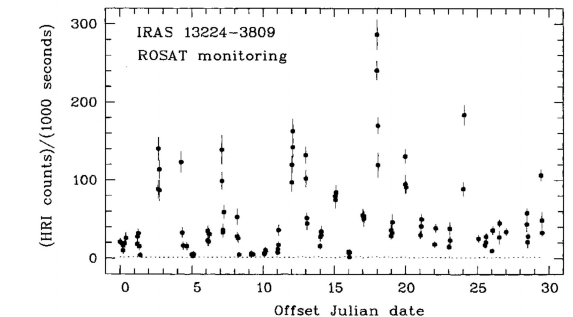
Figure 2: 30 day ROSAT monitoring of the NLS1 galaxy IRAS 13224-3809 taken in 1997. Persistent, gi- ant and rapid amplitude variations have been detected with the maximum amplitude variation with a factor of about 57.